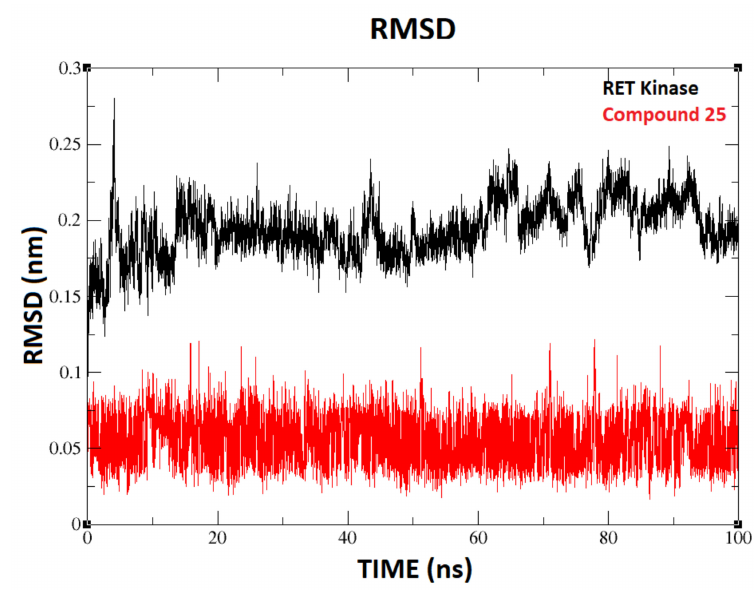
Figure 2. Root mean square deviations (RMSDs) of the protein and compound 25 .